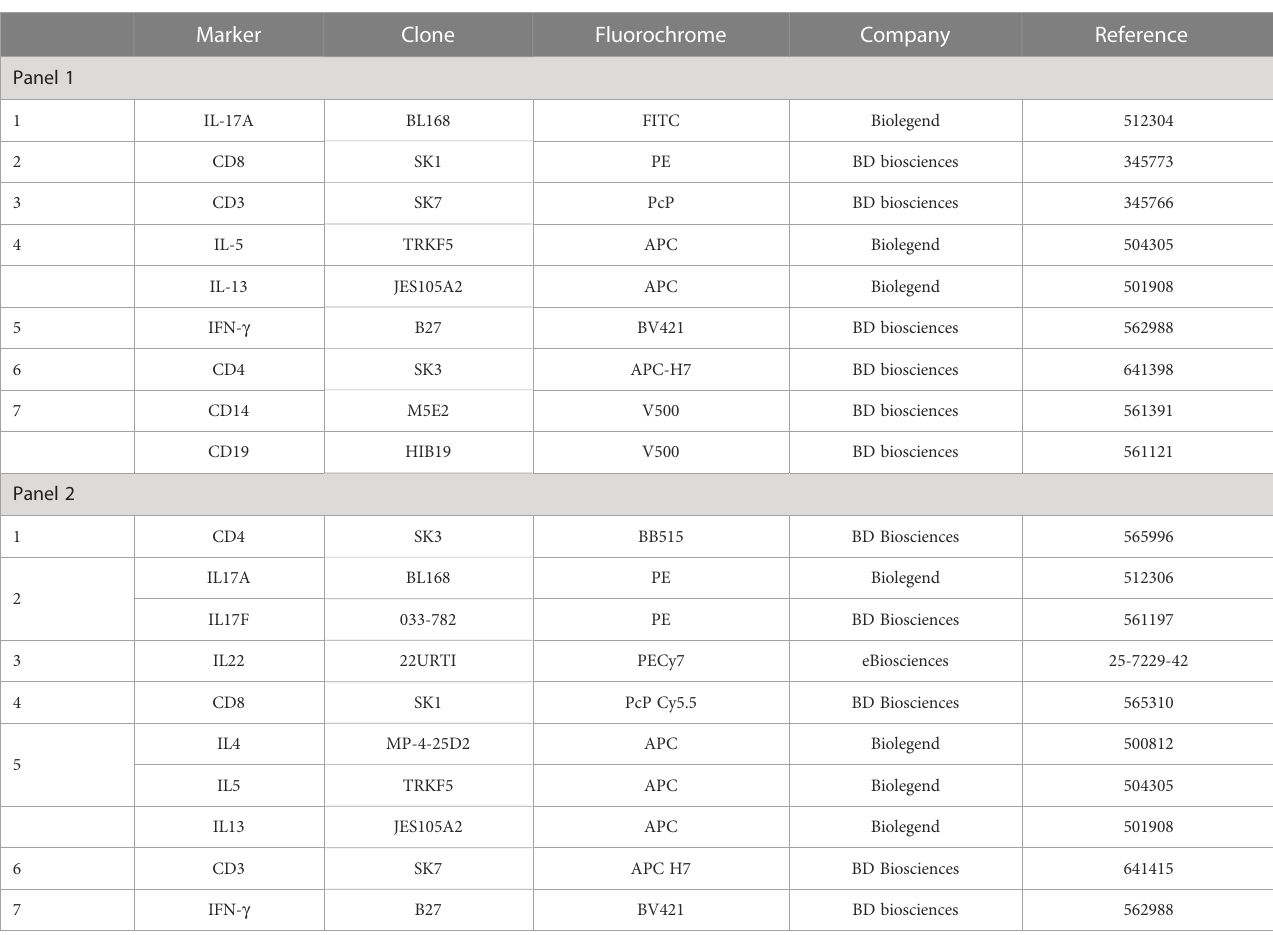
TABLE 1 Antibody clones and fl